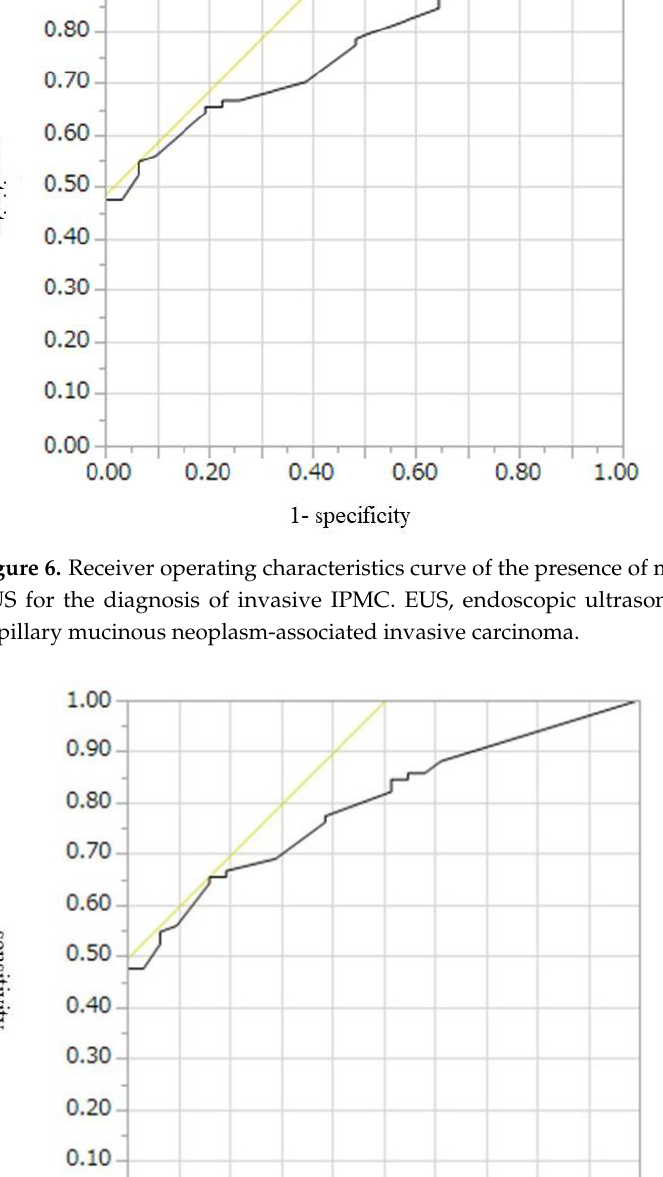
Figure 5. Receiver operating characteristics curve of the presence of mural lesions on contrast-en- hanced CT for the diagnosis of invasive IPMC. CT, computed tomography; IPMC, intraductal pa- pillary mucinous neoplasm-associated invasive carcinoma.